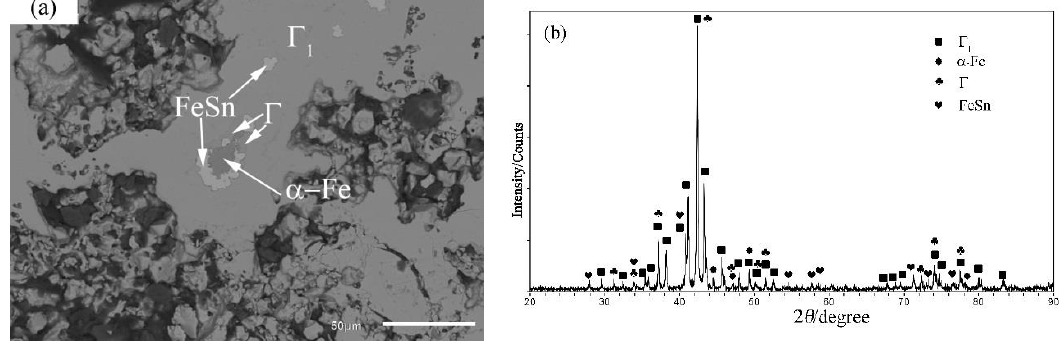
Figure 10. The microstructure ( a ) and XRD pattern ( b ) of Alloy A14.